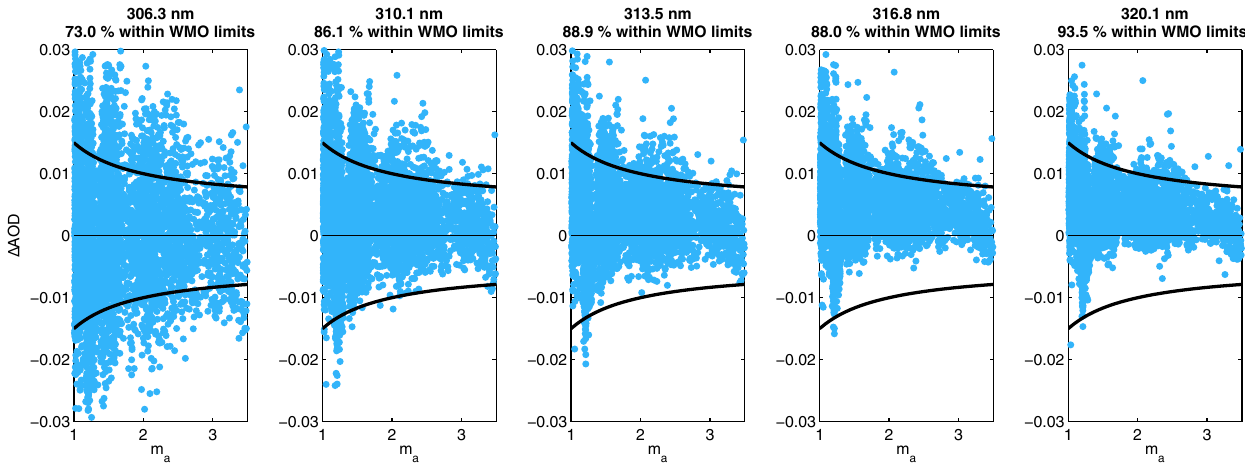
Figure 2. AOD differences between observations within 1min of the independently calibrated Brewers #183 and #185, plotted as a function of the aerosol optical air mass. The WMO traceability limits for finite field-of-view instruments (Eq. 11) are shown as thick black